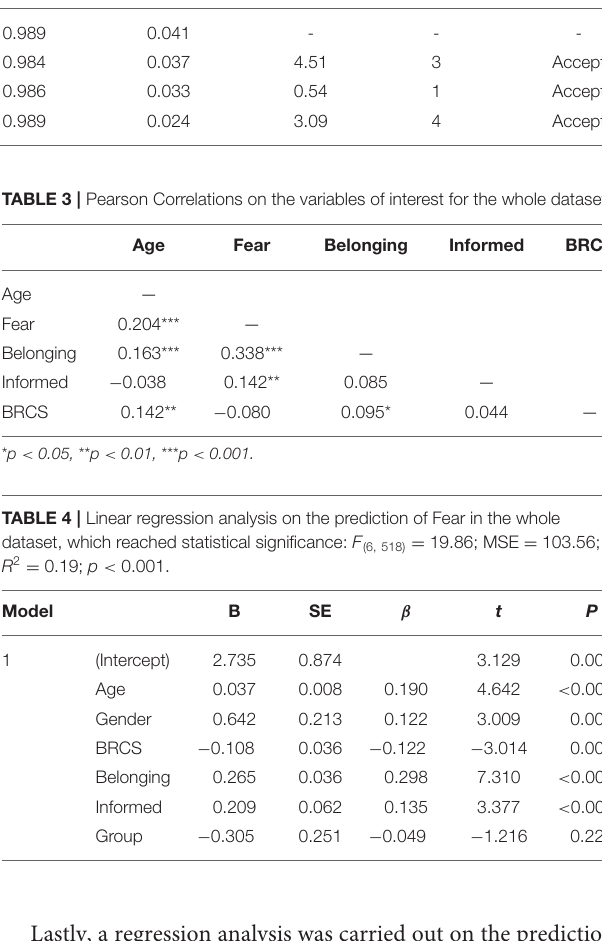
TABLE 2 | Analysis of invariance across migrant and non-migrant groups. Model